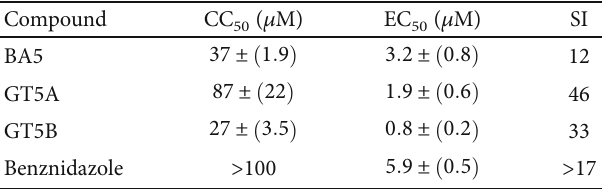
CC 50 : cytotoxicity concentration 50%; EC 50 : e ff ective concentration at 50% inhibitory concentration for inhibition of T. cruzi amastigotes. Values are means ± SD of three independent